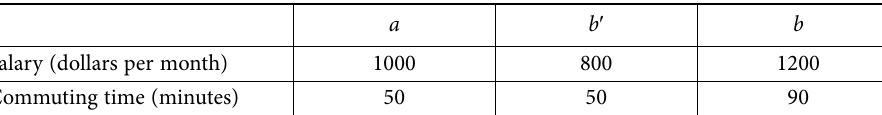
Table 2. The values after the trade-off a b ′ b Salary (dollars per month) 1000 800 1200 Commuting time (minutes) 50 50